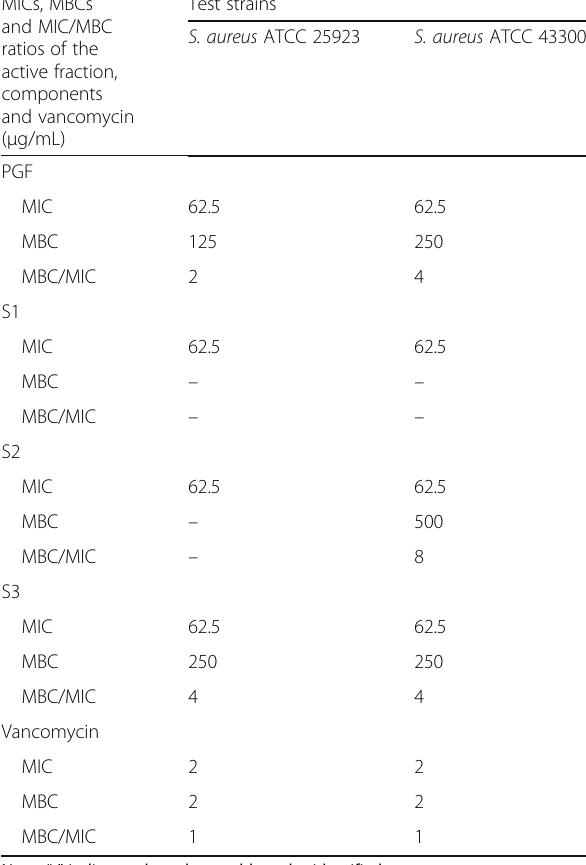
Table 3 MICs and MBCs of the PGF, S1, S2, and S3 MICs, MBCs and MIC/MBC ratios of the active fraction,